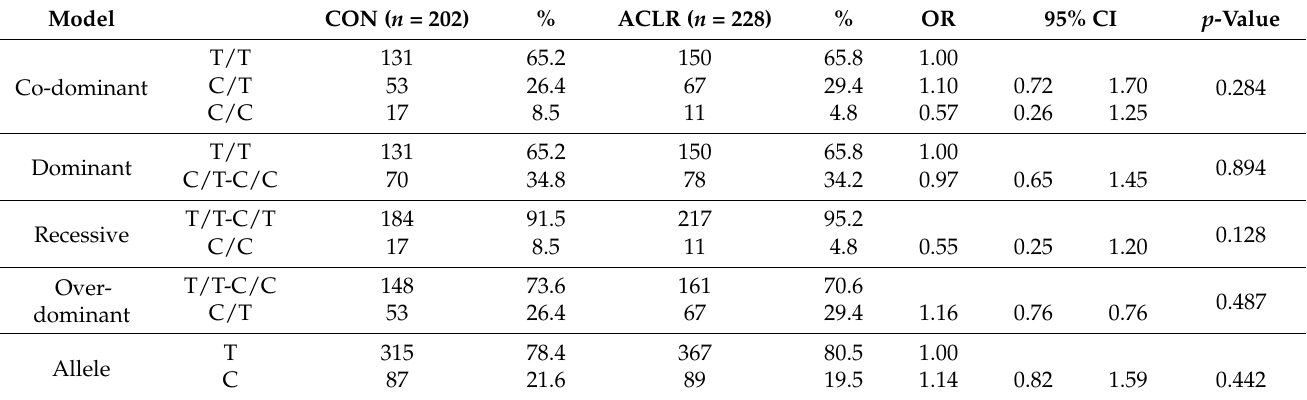
Table 3. Association analysis of the COL22A1 gene rs6577958 T/C polymorphism with non-contact ACL rupture.